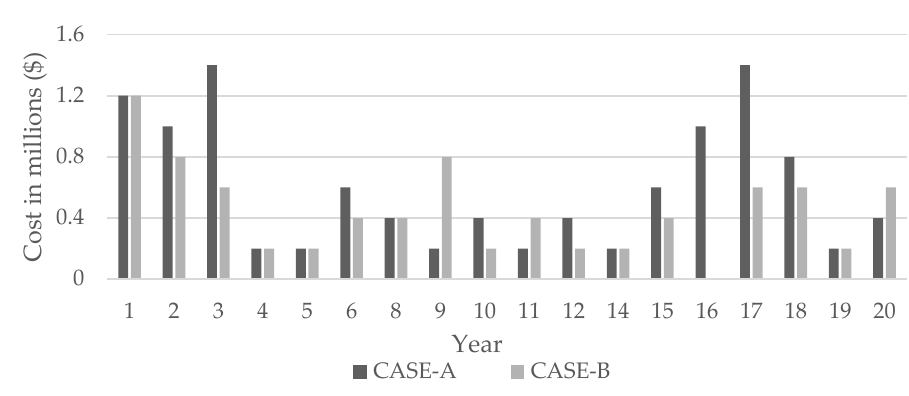
Figure 6. Annual lines’ upgrade cost comparison.